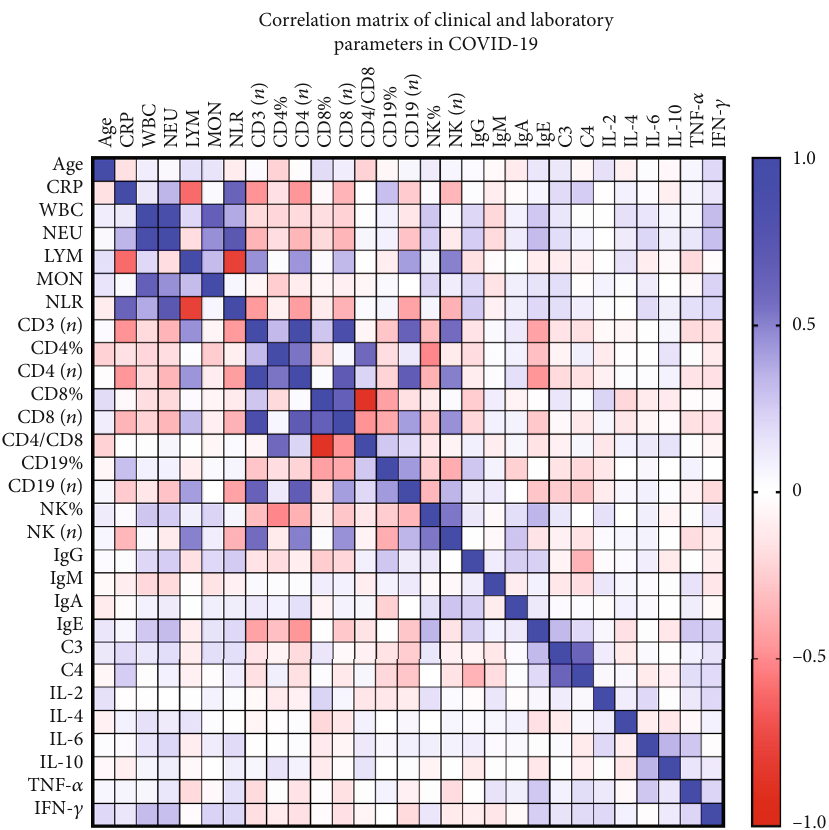
Figure 1: Correlation matrix of clinical and laboratory parameters in COVID-19 Spearman ’ s correlation coe ffi cients between two pairs of variables is shown in the heat map. The correlation coe ffi cients are represented in terms of the change of the intensity of red/blue color, as shown in the color bar. Table 3: Status of cellular immunity in patients with and without type 2 diabetes.